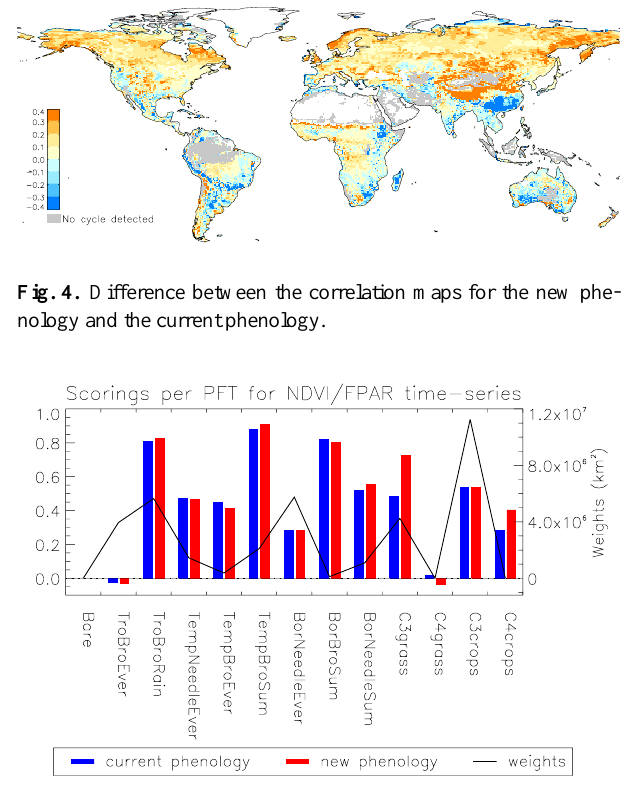
Fig. 5. Surface-weighted median values per PFT, for the NDVI/FPAR time series correlations. The blue bars are for the cur- rent phenology and the red bars for the new phenology. The black thick line indicates the total surface of the boxes used to assess the PFT median correlation.